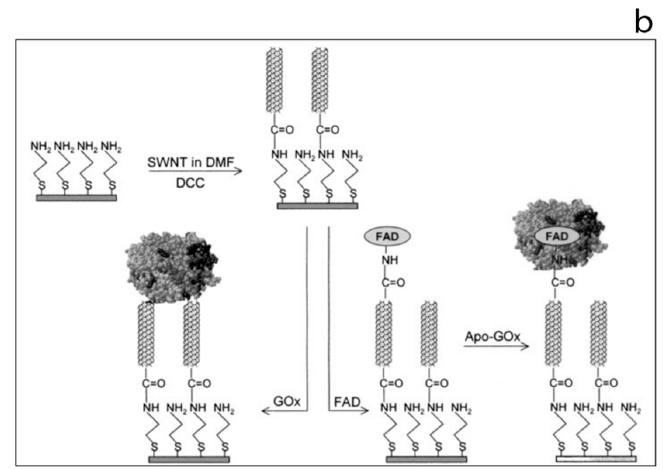
Figure 4. ( a ) Electrical wiring of glucose oxidase: (i) electrical contacting of glucose oxidase by reconstitution of apo-GOx on FAD-functionalized gold nanoparticles linked to an electrode surface by dithiol bridges, (ii) cyclic voltammograms obtained by the developed modified electrode in the presence of different glucose concentrations [37]. ( b ) Schematic image of the surface modification of gold electrode based on self-assembled monolayer with aligned single walled carbon nanotubes and their subsequent modification to allow direct electron transfer to glucose oxidase